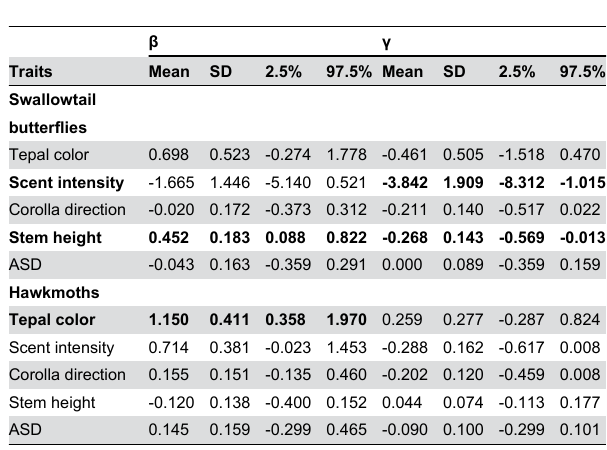
Table 1. Means and 95% confidence intervals of the posterior distribution of linear (β) and quadratic (γ) parameters in analyses of